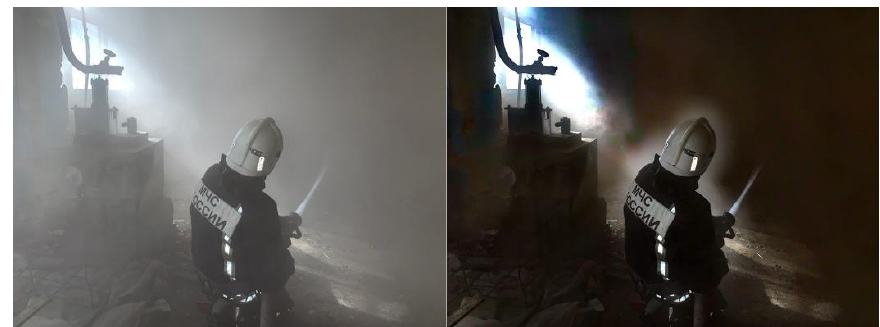
Fig. 10. Example No. 2 of the algorithm.